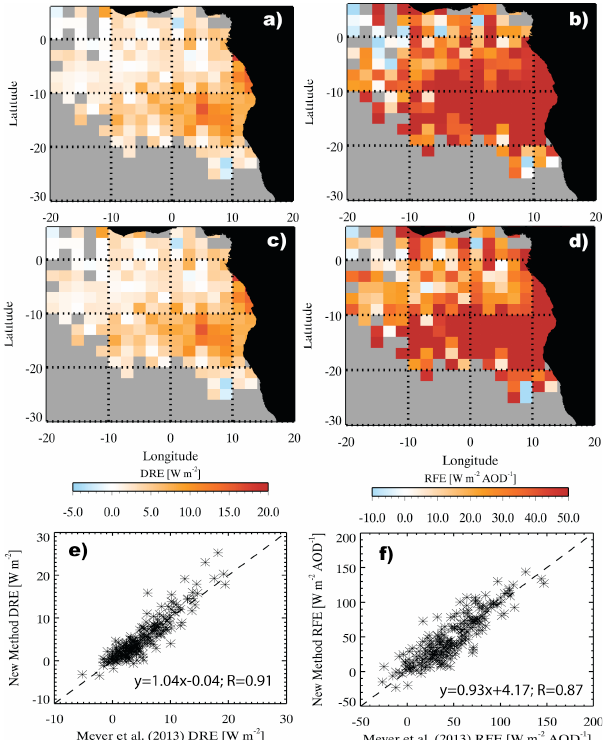
Figure 3 a) Seasonal mean (August/September 2007-2011) instantaneous TOA DRE of 2 Figure 3. (a) Seasonal mean (August/September 2007–2011) in- above-cloud smoke and polluted dust based on the pixel-level computations from (Meyer 3 stantaneous TOA DRE of above-cloud smoke and polluted dust et al., 2013); b) seasonal mean instantaneous TOA aerosol RFE (i.e., DRE per AOD) 4 from(Meyer et al., 2013); c) same as a), but based on the new method; d) same as b), but 5 based on the pixel-level computations from Meyer et al. (2013); based on the new method. 6 (b) seasonal mean instantaneous TOA aerosol RFE (i.e., DRE per AOD) from Meyer et al. (2013); (c) same as (a) , but based on the new method; (d) same as (b) , but based on the new method. Scatter plot of new method vs. Meyer et al. (2013) grid-mean (e) DRE and (f) RFE.